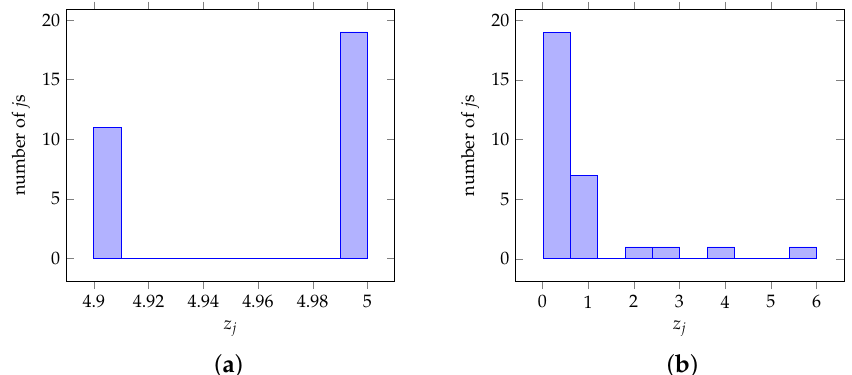
Figure 4. Values obtained from Examples 1 and 2. ( a ) Q (cid:48) = 0.9946, MSE = 0.8502. ( b ) Q (cid:48) = 0.0449, MSE = 0.0018.